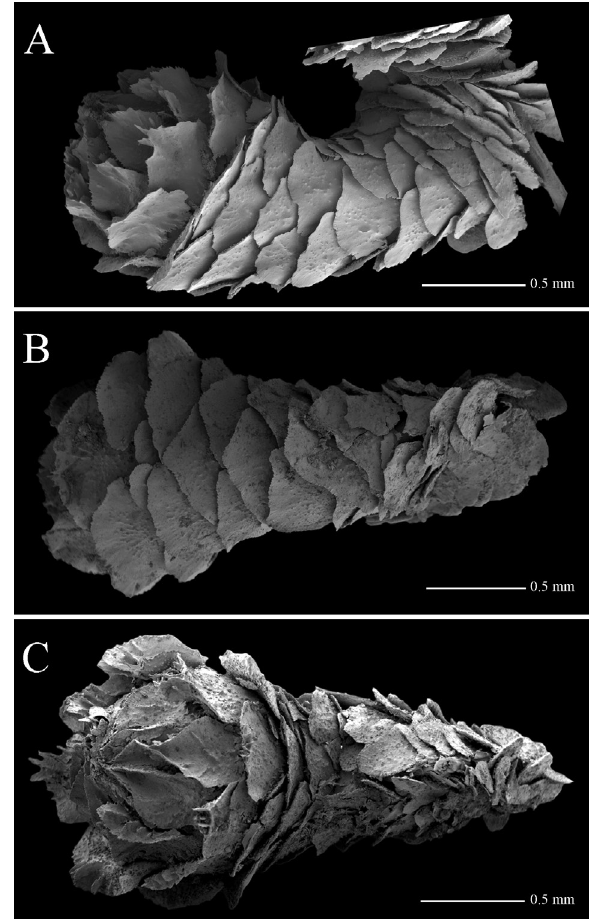
Fig . 12. – Thouarella grandiflora Kükenthal, 1912: A, holotype (ZMB Cni 5469), polyp on lateral view; B, paralectotype (MPUW 44), polyp on abaxial view; C, paralectotype (MPUW 44), polyp on adaxial